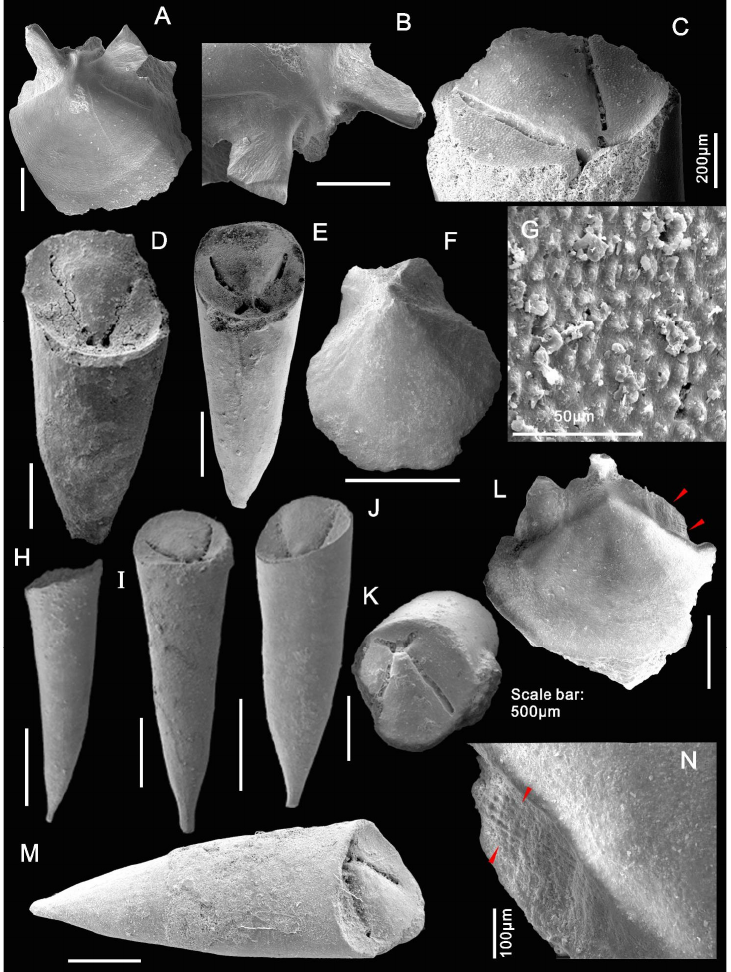
Figure 3. Internal moulds of Doliutheca orientalis from SSF assemblages of the Shipai Formation at the Xiachazhuang section, Hubei Province, China. ( A , B ) Mold of operculum in external view noting prominent cardinal process in the enlarged view in ( B ). ELI QJP-SP-H-SSF-8101001. ( C ) The granular texture on the operculum imprint. ELI QJP-SP-H-SSF-81019. ( D – E ) Internal molds with conch and opercula, showing the X-shaped imprint caused by the clavicles and cardinal process. ( D ) ELI QJP-SP-H-SSF-61035. ( E ) ELI QJP-SP-H-SSF-816001. ( F ) external view of operculum, showing the convex conical shield and flat cardinal shield. ELI QJP-SP-H-SSF-7109. ( G ) Close-up of tubercles on the conch surface. ELI QJP-SP-H-611002003. ( H ) lateral view of conch showing the rounded smooth lateral transition between dorsum and venter and slight dorsal curvature of conch. ELI QJP- SP-H-SSF-811107. ( I ) Conch with articulated operculum in dorsal view. ELI QJP-SP-H-SSF-810405. ( J ) Conch with articulated operculum in dorsal view, note gradual expansion of conch from the sharp apex to aperture. ELI QJP-SP-H-8104039. ( K ) Apertural view of conch with articulated operculum, noting the rounded conch cross-section with deep imprint of operculum. ( L , N ) Internal mold of operculum showing the exposed clavicle with rod-shaped elements of the clavicle (marked by red arrows), with the close-up view in ( N ). ELI QJP-SP-H-SSF-8102017. ( M ) Lateral view of conch with articulated operculum. ELI